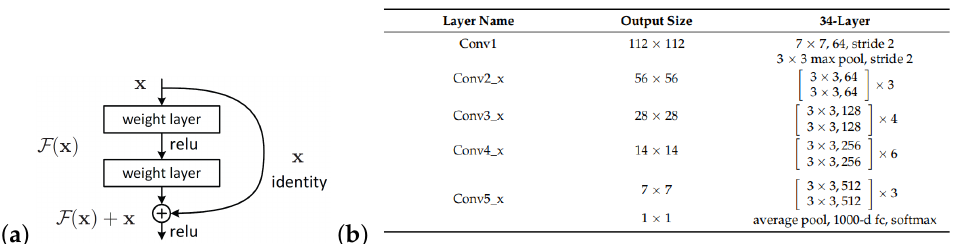
Figure 8. ResNet34: ( a ) “Basic-Block” building block; ( b ) The structure of ResNet34 (from